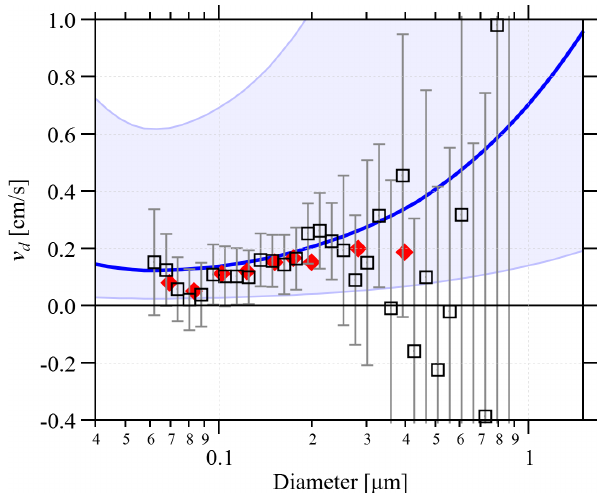
Figure 7. Size-resolved deposition velocities from this study (black squares) with error bars showing standard errors (68% confidence interval). Data are overlaid on the Emerson et al. (2020) mea- surements (red diamonds) and parameterization (blue line with 5 × bounding range). Emerson et al. (2020) measurements are over a ponderosa pine forest, and the parameterization is for needleleaf forest (their Fig. 1).